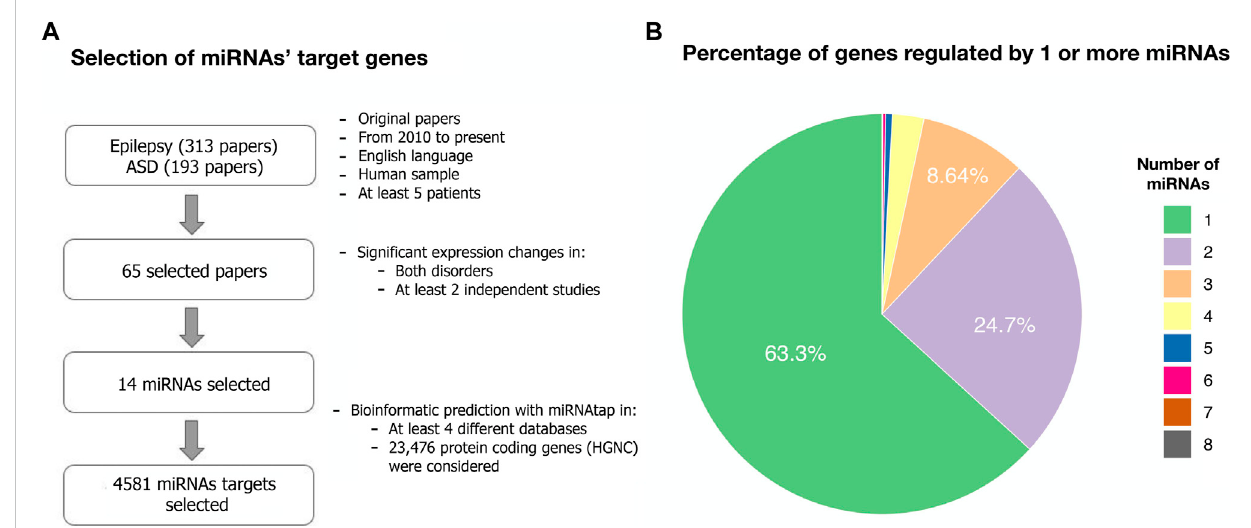
FIGURE 1 Target genes from dysregulated miRNAs in both ASD and epilepsy. (A) Flowchart describing the systematic search for dysregulated miRNAs in both ASD and epilepsy and their target genes (Methods). The search terms and the list of selected papers can be found in Supplementary Data Sheet S2 – 3. (B) Percentage of the 4,581 predicted target genes regulated by one or more of the selected 14